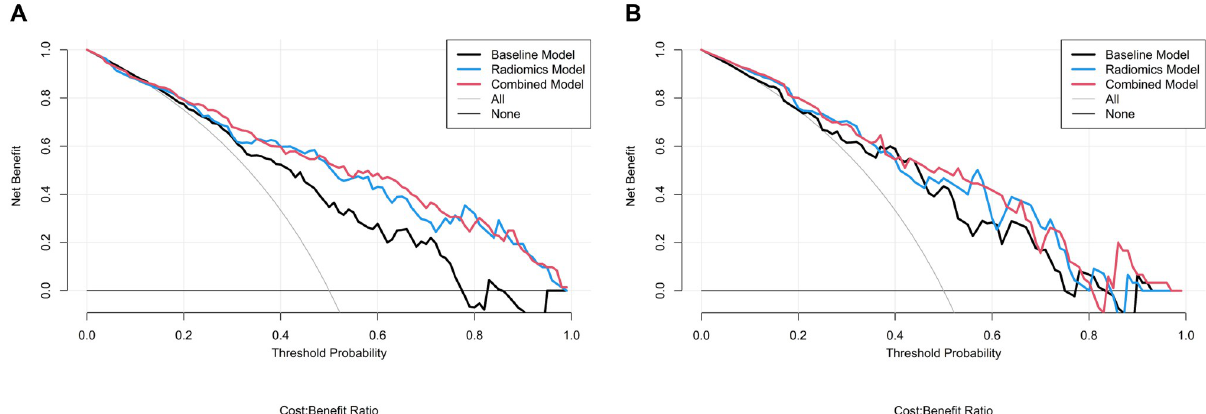
Fig 5. Decision curves of the three models for the training (A) and test (B) cohorts. https://doi.org/10.1371/journal.pone.0269356.g005 Table 4. Performance of the three prediction models in the external validation cohort. AUC 95% CI SEN SPE ACC